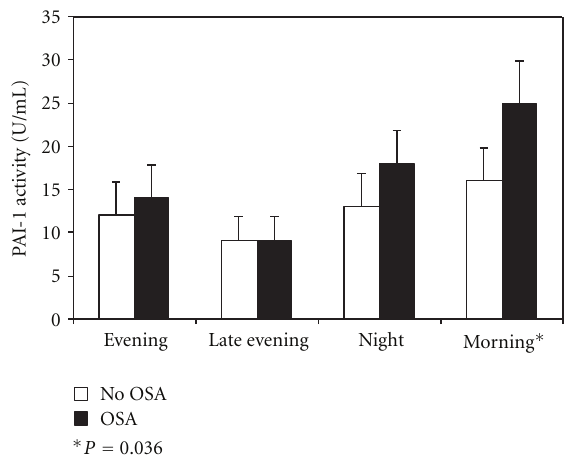
Figure 1: PAI-1 activity (95% CI) in subjects with OSA and